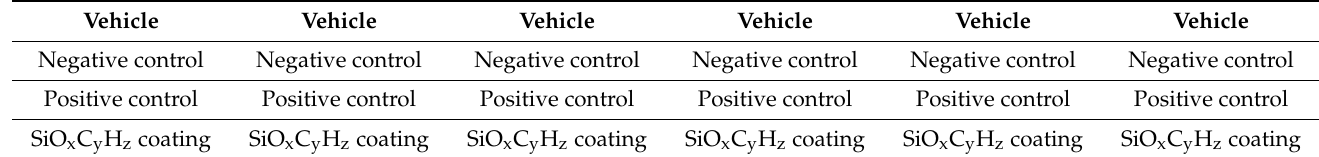
Table 2. Schematic representation of the Neutral red assay on a 24-well plate according to the ISO 10993–5:2009, Annex A. Vehicle Vehicle Vehicle Vehicle Vehicle Vehicle Negative control Negative control Negative control Negative control Negative control Negative control Positive control Positive control Positive control Positive control Positive control Positive control SiO x C y H z